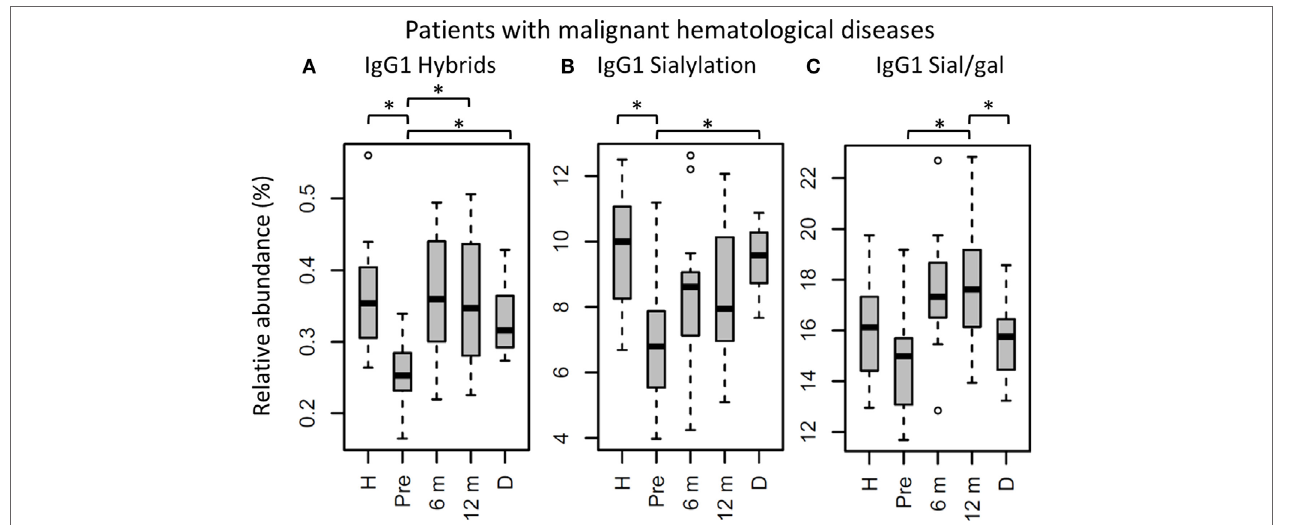
FigUre 5 | IgG1 fragment crystallizable (Fc) glycosylation features in patients with malignant hematological diseases, compared to their donors and age-matched healthy controls. IgG1 (a) hybrid-type glycans and (b) sialylation differ between healthy controls (H) and patients before hematopoietic stem cell transplantation (HSCT) (Pre). In addition, IgG1 (a) hybrid-type glycans and (b) sialylation are different between patients and donors (D), and IgG1 (a) hybrid-type glycans and (c) sialylation per galactose change within the patients after HSCT. 6 m: patients 6 months after HSCT, 12 m: patients 12 months after HSCT. Patients and donors were compared by Wilcoxon signed-rank tests, healthy controls and patients with Mann–Whitney U tests. p- Values < 0.015 were considered statistically significant after 5% FDR correction (as indicated by the asterisks above the plots). For all IgG1 glycosylation features in patients treated for malignant hematological diseases, n (H, Pre, 6 m, 12 m, D) = 16, 16, 16, 16, 15, respectively.